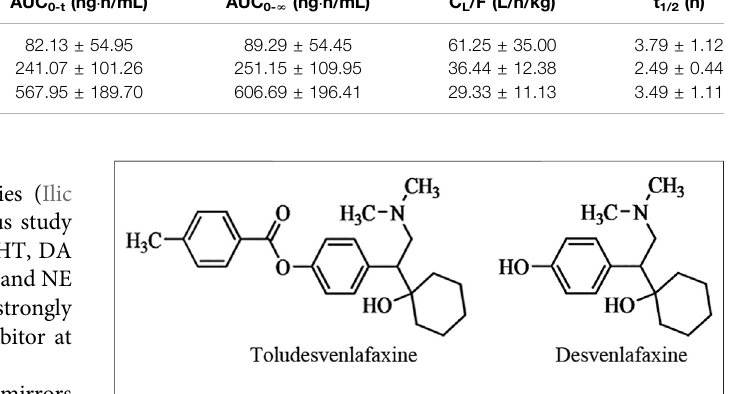
FIGURE 1 | The chemical structure of toludesvenlafaxine and